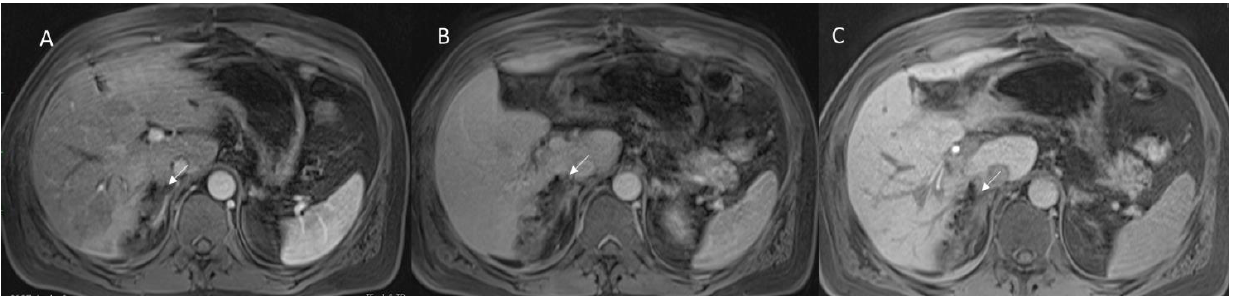
Figure 1. Postsurgical biloma assessed with MRI at 1 week post resection of VIII segment for liver metastasis. The biloma (arrow) appears hyperintense in T2 ( A , B ) sequences of MRI study.